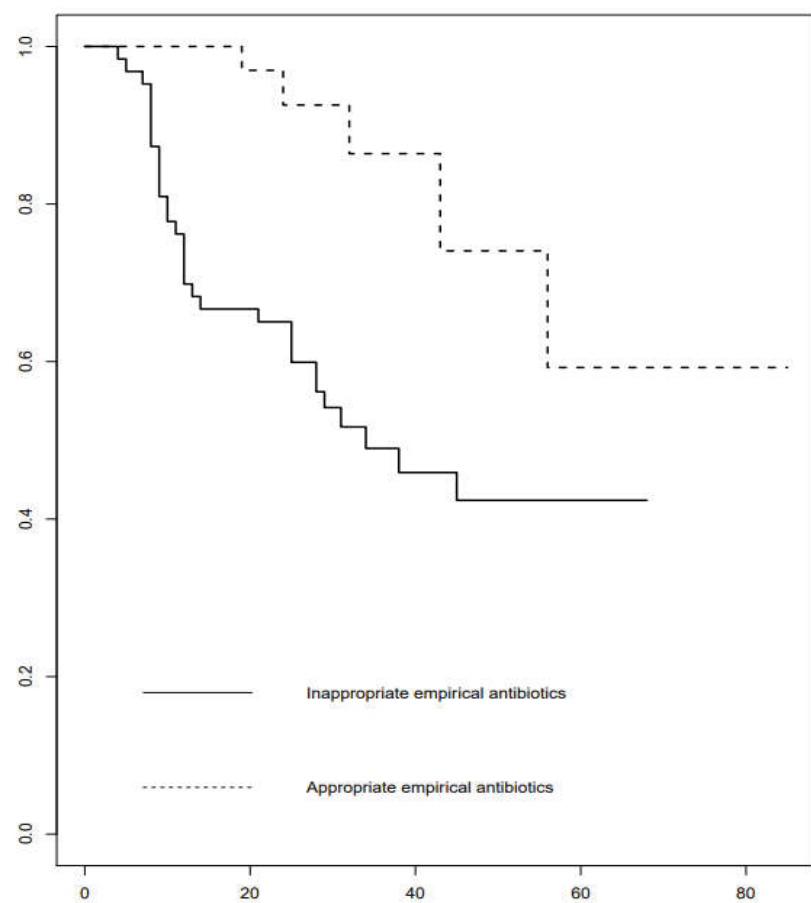
Figure 2. Kaplan–Meier survival curves of S. maltophilia bacteremia patients who received and did Figure 2 . Kaplan – Meier survival curves of S . maltophilia bacteremia patients who received and did not receive appropriate empirical not receive appropriate empirical antibiotic ( s ).